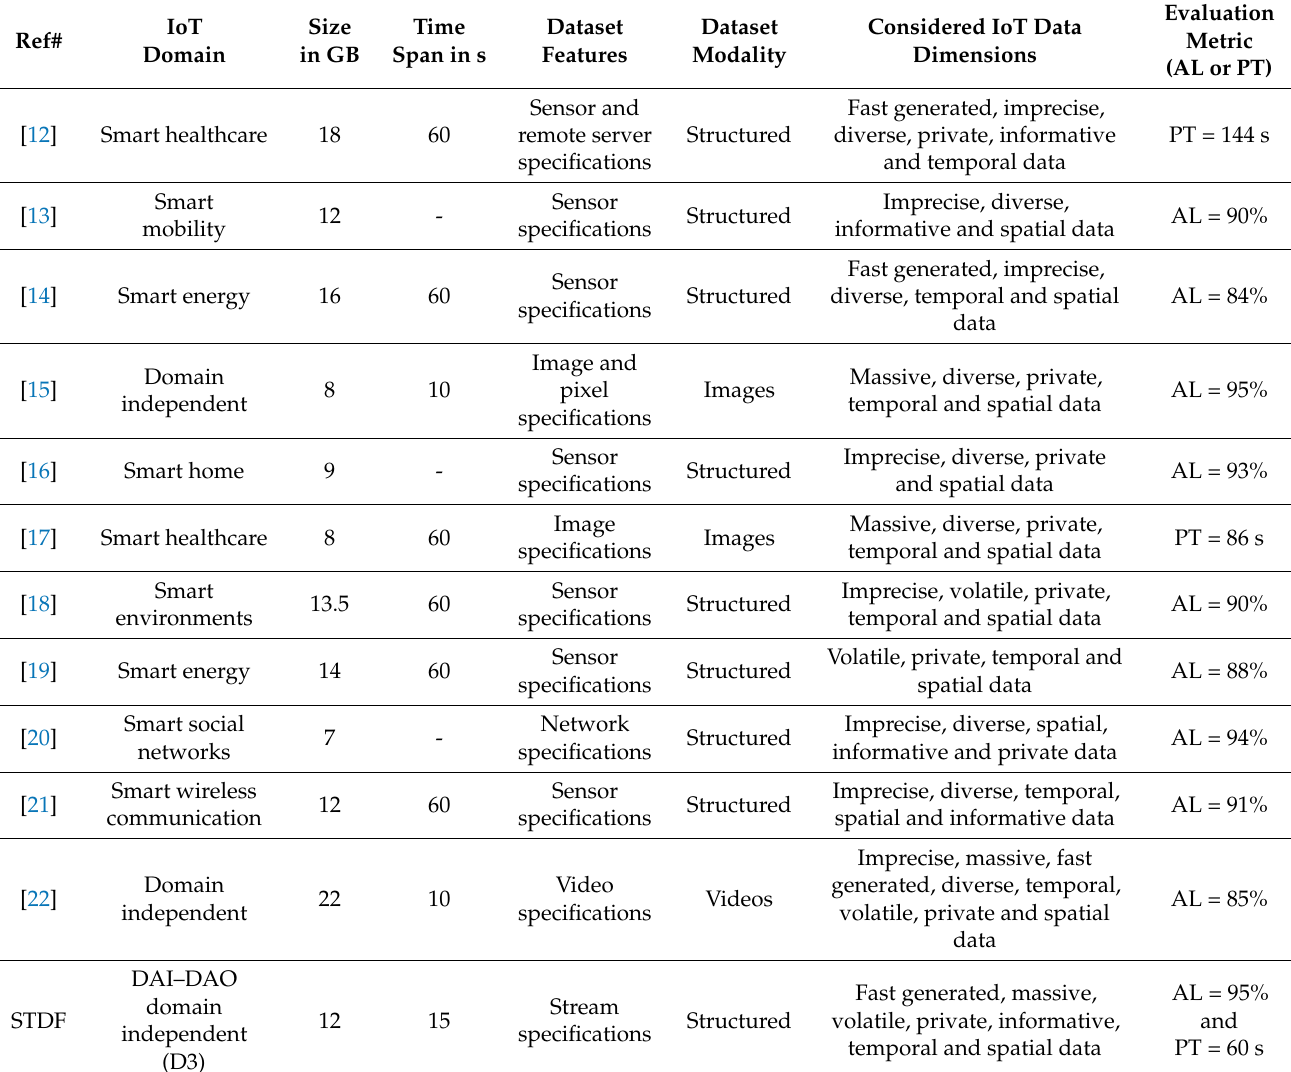
Table 7. Summarized description of the main considered datasets for the comparative